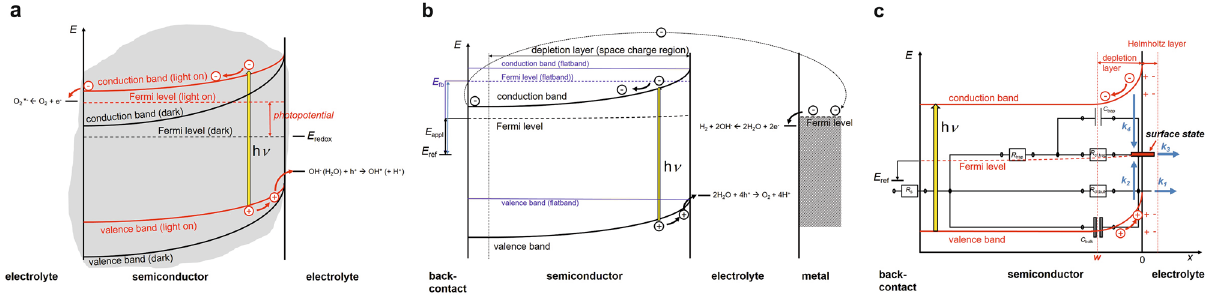
Figure 1. Energy schemes for a photocatalytically active n-type semiconductor particle ( a ) and a photoelectrochemical cell with an n-type semiconductor electrode as photoanode ( b ) with depletion layer, interfacial semiconductor-electrolyte charge transfer, and possible redox reactions. ( c ) Schematic band diagram with charge transfer rate constants and equivalent circuit elements used to fit EIS